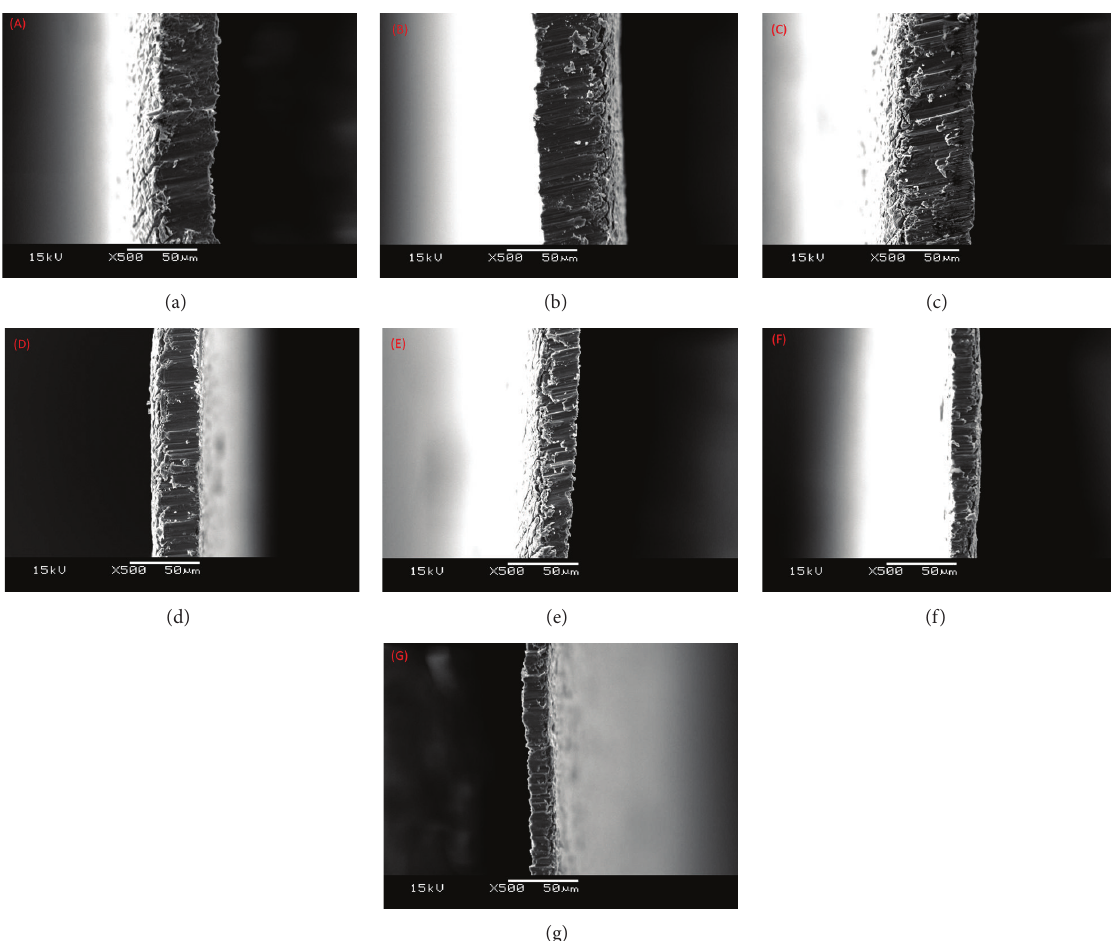
Figure 5: Cross-section morphologies of chemical etching under different times (a) 10min, (b) 11min, (c) 12min, (d) 13min, (e) 14min, (f) 15min, and (g) 16min.